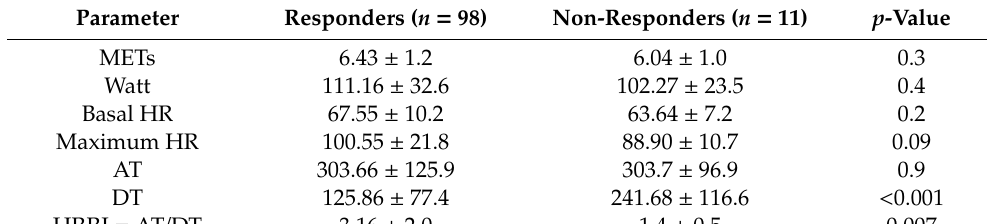
Table 4. Comparison of exercise test (ET) parameters between responders and non-responders. MET, metabolic equivalents of task; HR, heart rate.